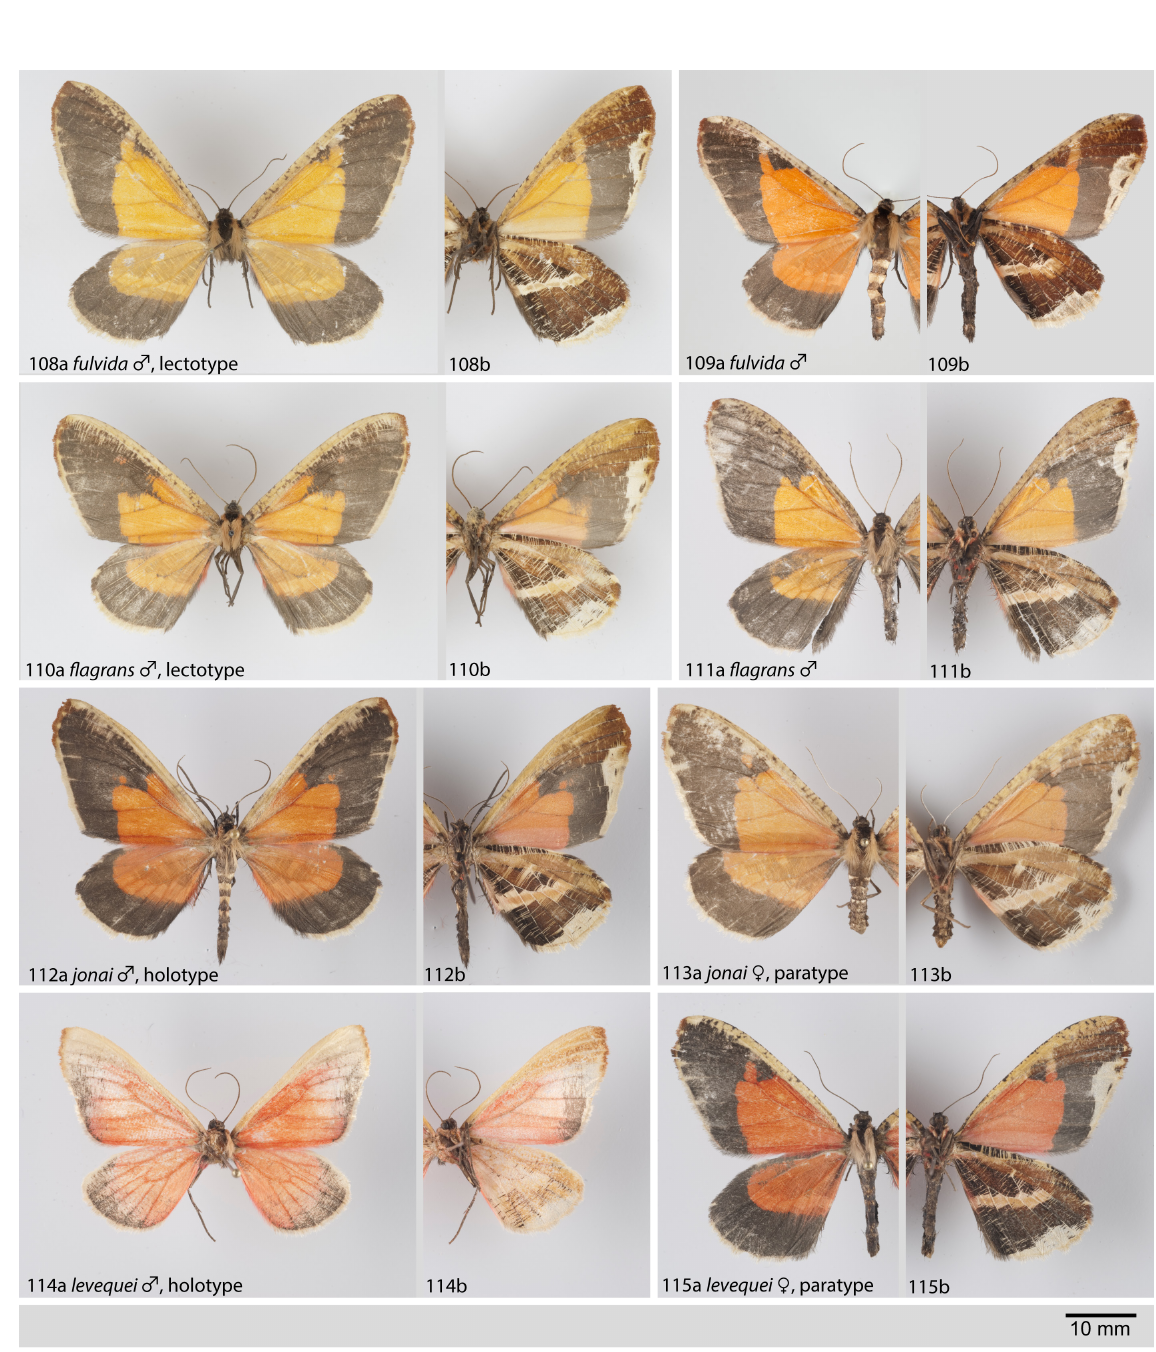
Figs 108–115. Adult moths (a = dorsal view; b = ventral view). 108 . Callipia fulvida Warren, 1907, ♂, lectotype (NHM). 109 . C. fulvida Warren, 1907, ♂ (C-0174, COI data). 110 . C. flagrans Warren, 1904, ♂, lectotype (NHM). 111 . C. flagrans Warren, 1904, ♂ (C-0022, COI data). 112 . C. jonai sp. nov., ♂, holotype (C-0020, COI data). 113 . C. jonai sp. nov., ♀, paratype (C-0217). 114 . C. levequei sp. nov., ♂, holotype (C-0073, COI data). 115 . C. levequei , ♀, paratype (C-0071, COI